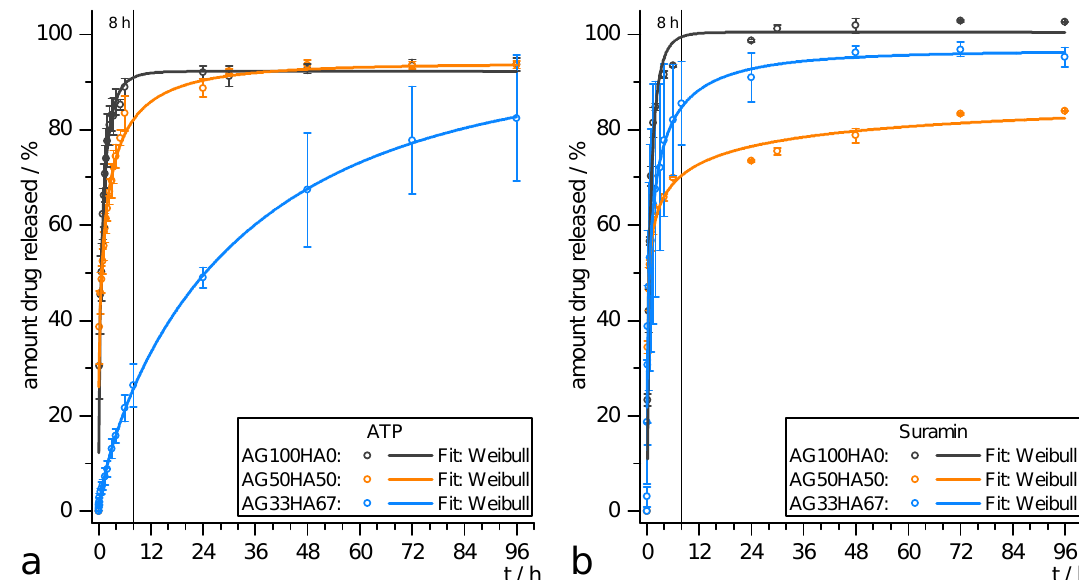
Figure 7. Release data of ( a ) ATP and ( b ) suramin from AG100HA0 (black), AG50HA50 (orange), and AG33HA67 (blue) scaffolds. Data fit: Weibull equation M = M f · ( 1 − e